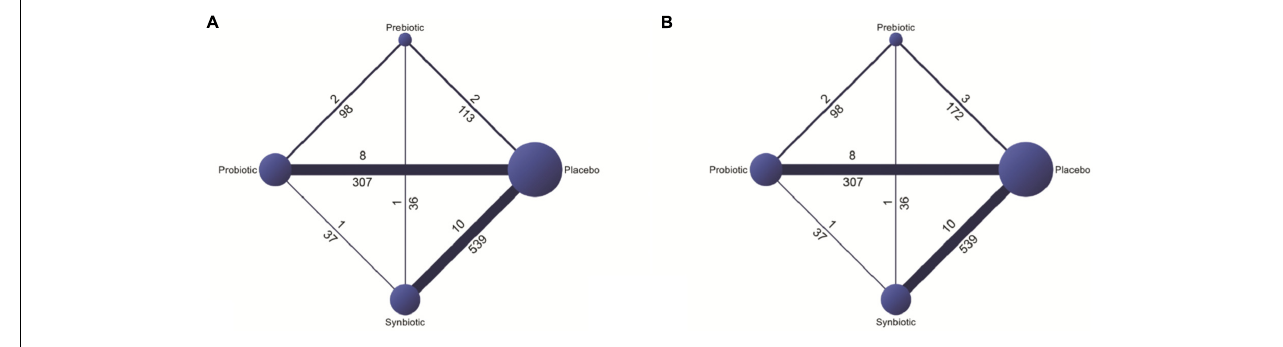
FIGURE 2 | Networks of all options comparisons for reduction in (A) aspartate aminotransferase (AST) and (B) alanine aminotransferase (ALT).